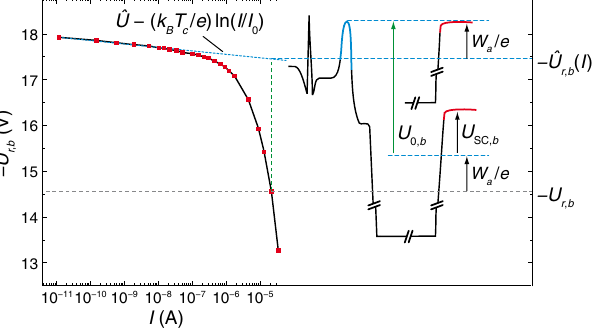
FIG. 5. Calibration of the applied retarding voltage at the breaking point ( U ) to yield the actual potential difference U 0 r;b between the electron source and the drift tube. The dotted line through the data in the low-current region denotes the fitted ˆ U ð I Þ using Eq. (9). The drift tube potential reference values r;b U 0 with respect to the virtual electron source is obtained as the ;b − ˆ U ð I Þ . difference U r;b r;b